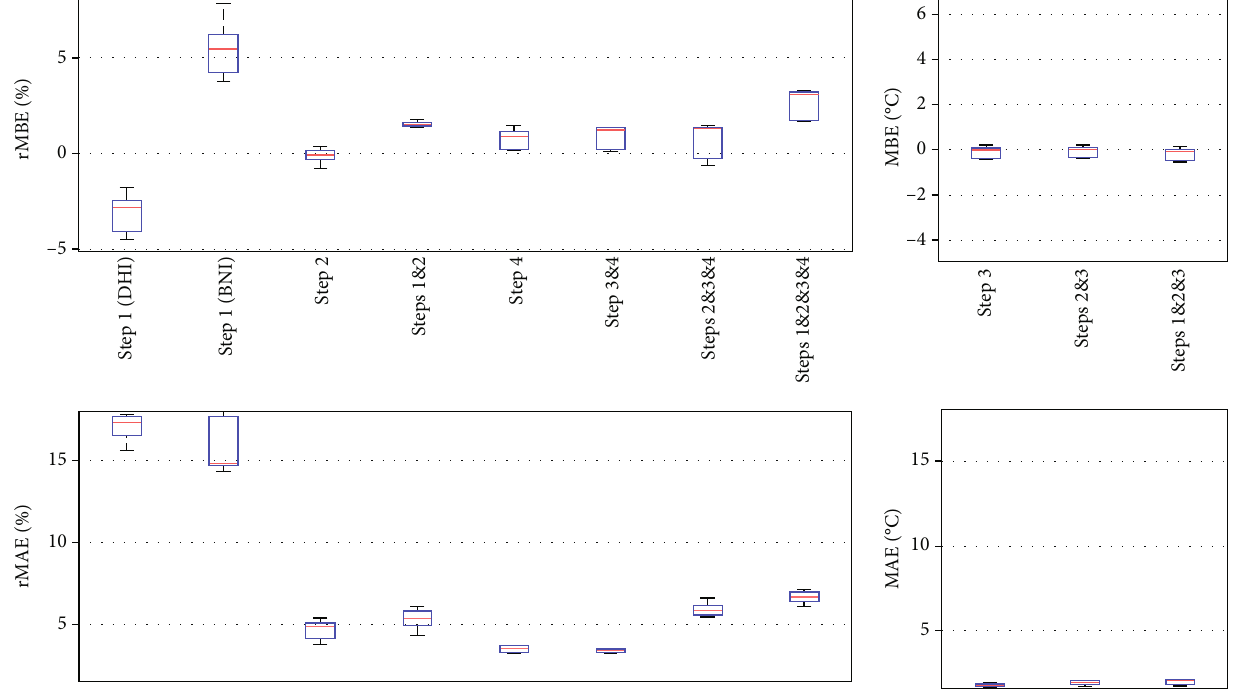
Figure 7: Modeling error estimation in each step of the simulation process for SIRTA measurements. The models are Helbig (step 1), Klucher (step 2), Adv. NOCT (step 3), and Evans (step 4). Computed data can be found in Figure 10 of Appendix